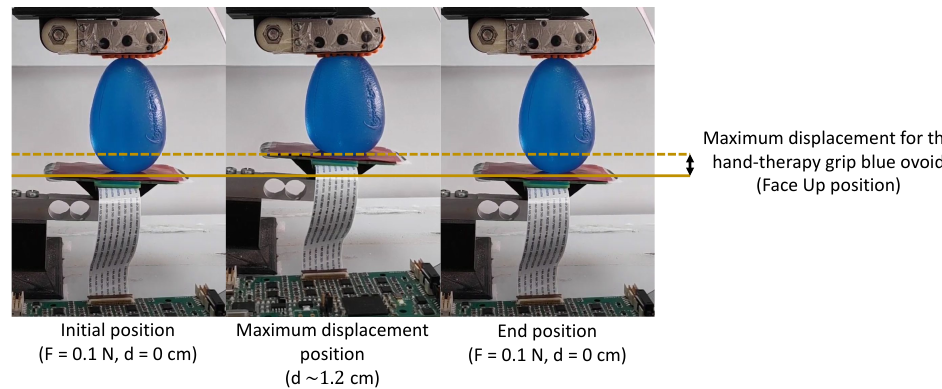
Figure 5. Illustration of the exploration sequence for the object class #OBJ-17.